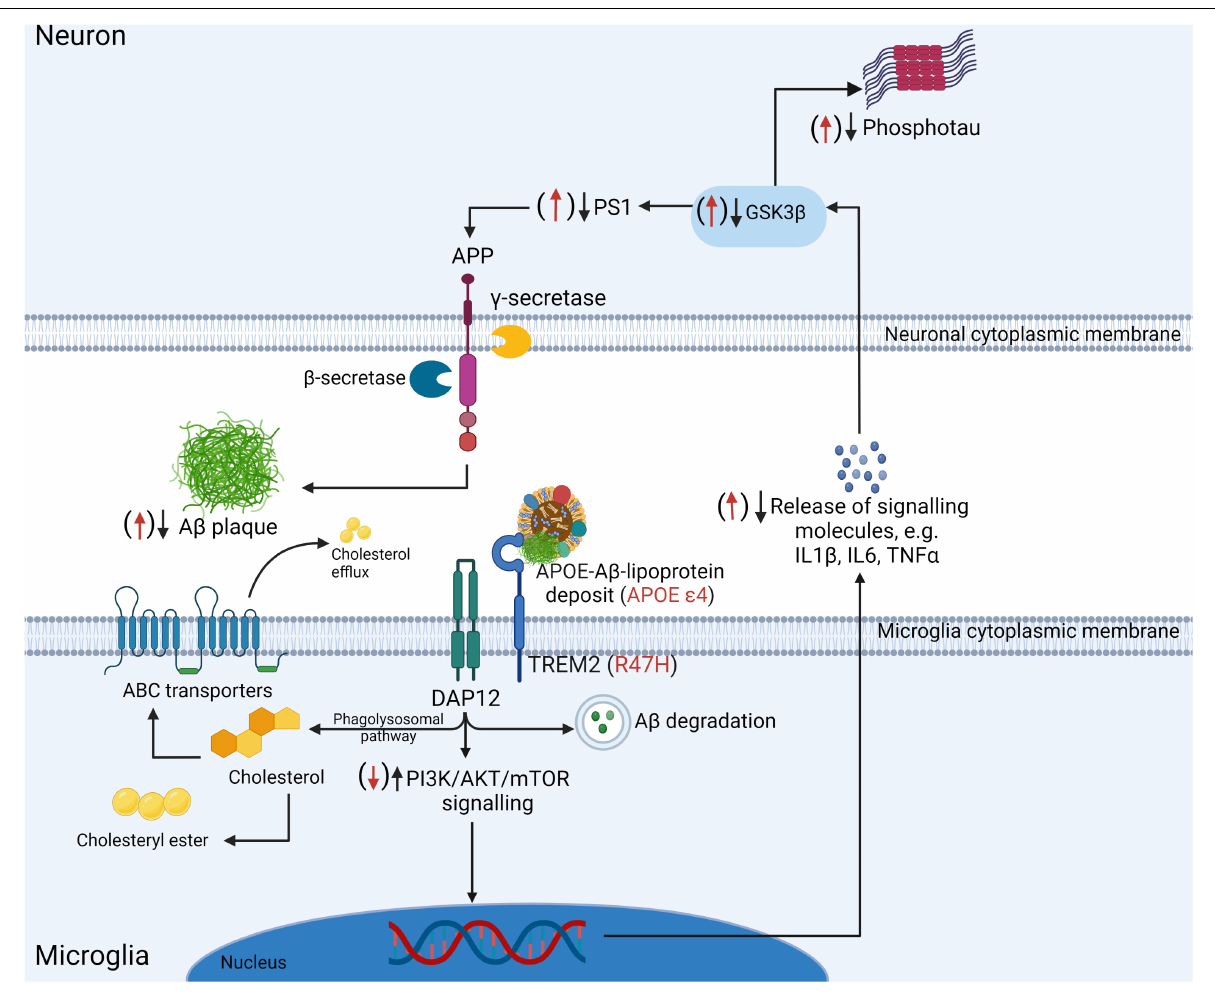
FIGURE 2 | Under physiological conditions TREM2 facilitates the phagocytosis of APOE-lipoprotein-bound A β . Lipid molecules are processed by the intracellular phagolysosomal system to yield free cholesterol which may be stored internally as cholesteryl esters or secreted by ATP-binding cassette (ABC) transporters. A β may be degraded in autophagic vacuoles, via the ubiquitin-proteasomal system, or by any of a number of A β -degrading proteases including the metalloendopeptidase and matrix metalloproteinase families of catabolic enzymes. Furthermore, DAP12 activation following TREM2 binding results in the activation of the PI3K/AKT/mTOR signalling cascade which reduces the secretion of signalling molecules such as IL1 β , IL6, and TNF α which in turn is associated with reduced activation of intraneuronal GSK3 β —an important protein kinase responsible for tau phosphorylation and which is also involved in the activation of γ -secretase through its interaction with presenilin 1. The R47H loss of function mutation in TREM2 and the APOE ε 4 allele (both indicated in red) represent two factors which impair A β and lipid processing by microglia. Abnormal TREM2/DAP12 signalling may result in reduced PI3K/AKT/mTOR signalling and disinhibition of IL1 β , IL6, and TNF α secretions, leading to increased intraneuronal phosphotau and the exacerbation of A β accumulation (indicated by the red arrows). Created with